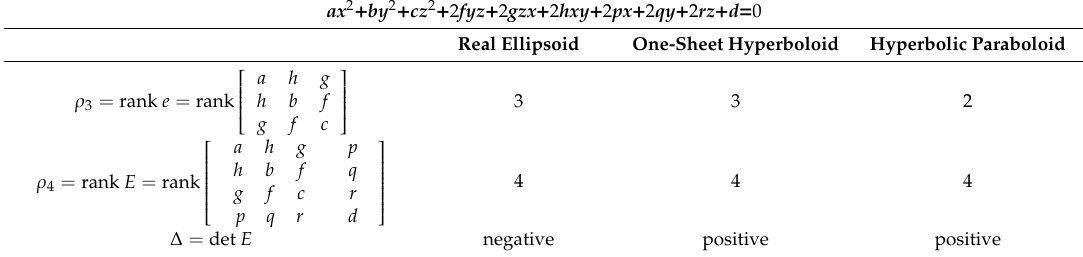
Table 1. General quadratic equation in three variables and definition of the properties satisfied by the quadratic surfaces of interest for particle analysis [60–63].